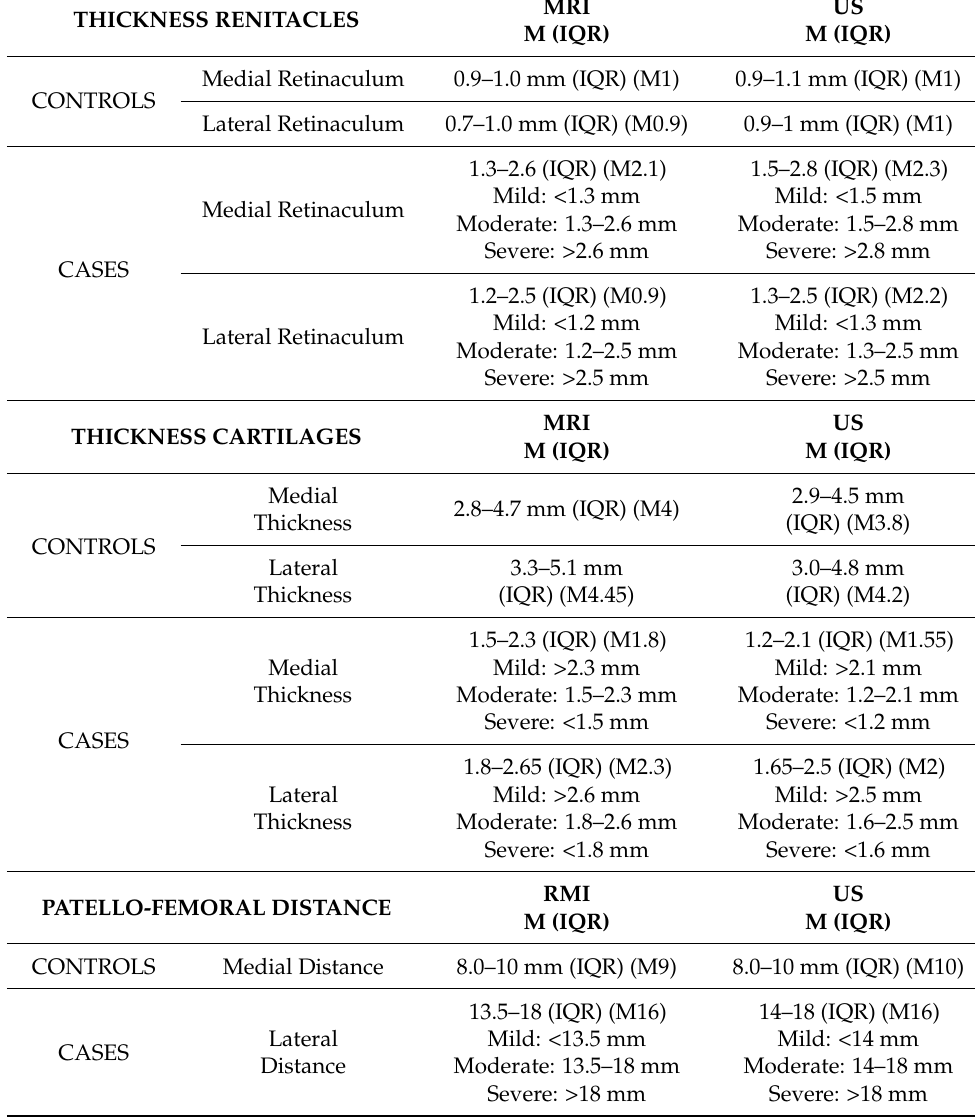
Table 1. Descriptive analysis of all instrumental measurements. Median and Interquartile Range values of the parameters analyzed (thickness of retinacles and trochlear cartilages, and medial patello-femoral distance) in US and MRI in healthy controls and pathological cases, with interquartile stratification in pathological cases to differentiate the severity